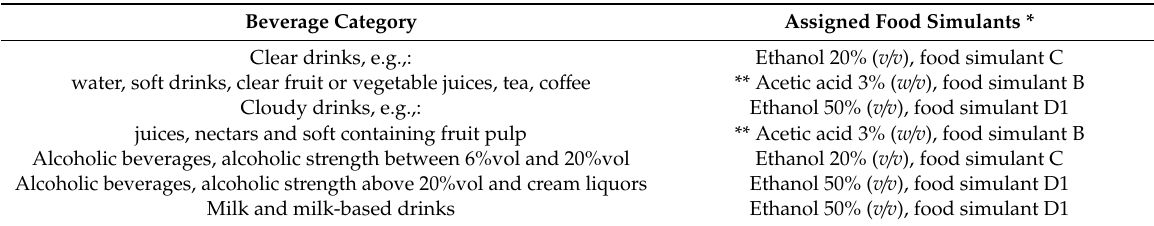
Table 2. Food simulants according to Regulation (EU) No 10 / 2011 assigned to different beverage categories. Beverage Category Assigned Food Simulants * Clear drinks, e.g.,: